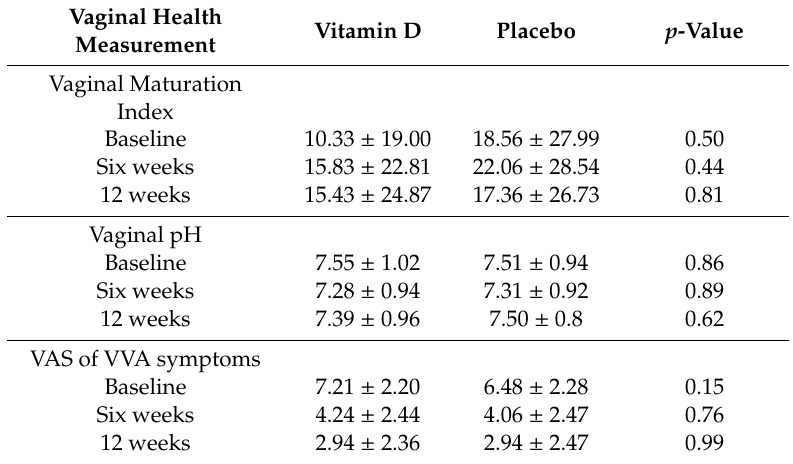
Table 2. Comparison of the vaginal health measurement between vitamin D group and placebo group at baseline, six, and 12